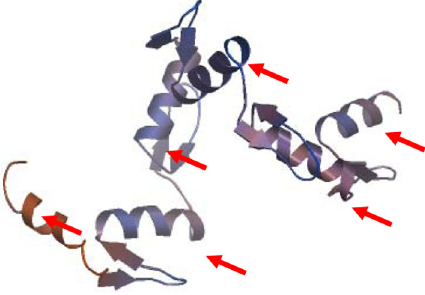
Figure 1. Structure of ZNF667. Arrows: zinc finger structure.